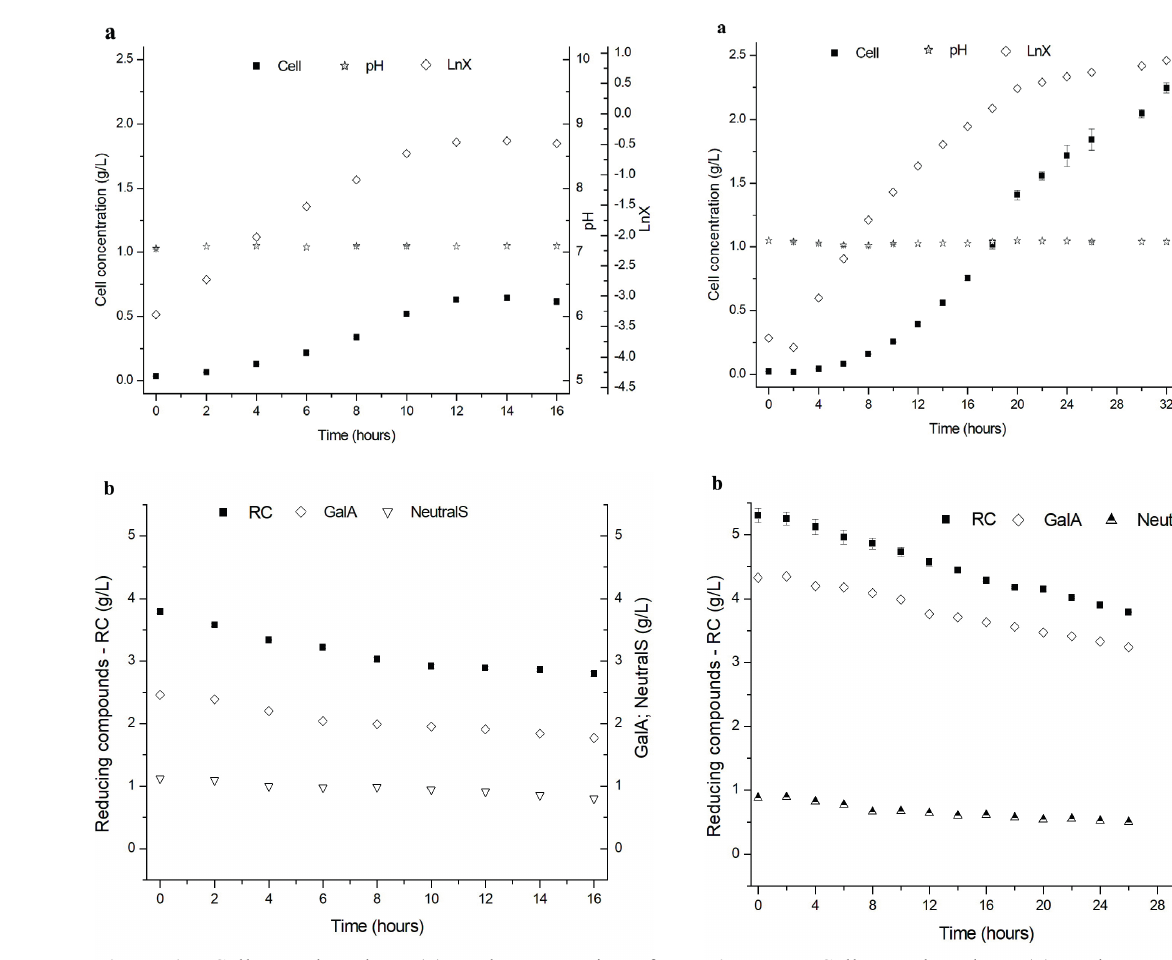
Figure 4 – Cell growth and pH ( a ); and consumption of substrates ( b ), during culture of C. necator in mineral media containing chemical pectin hydrolysate.